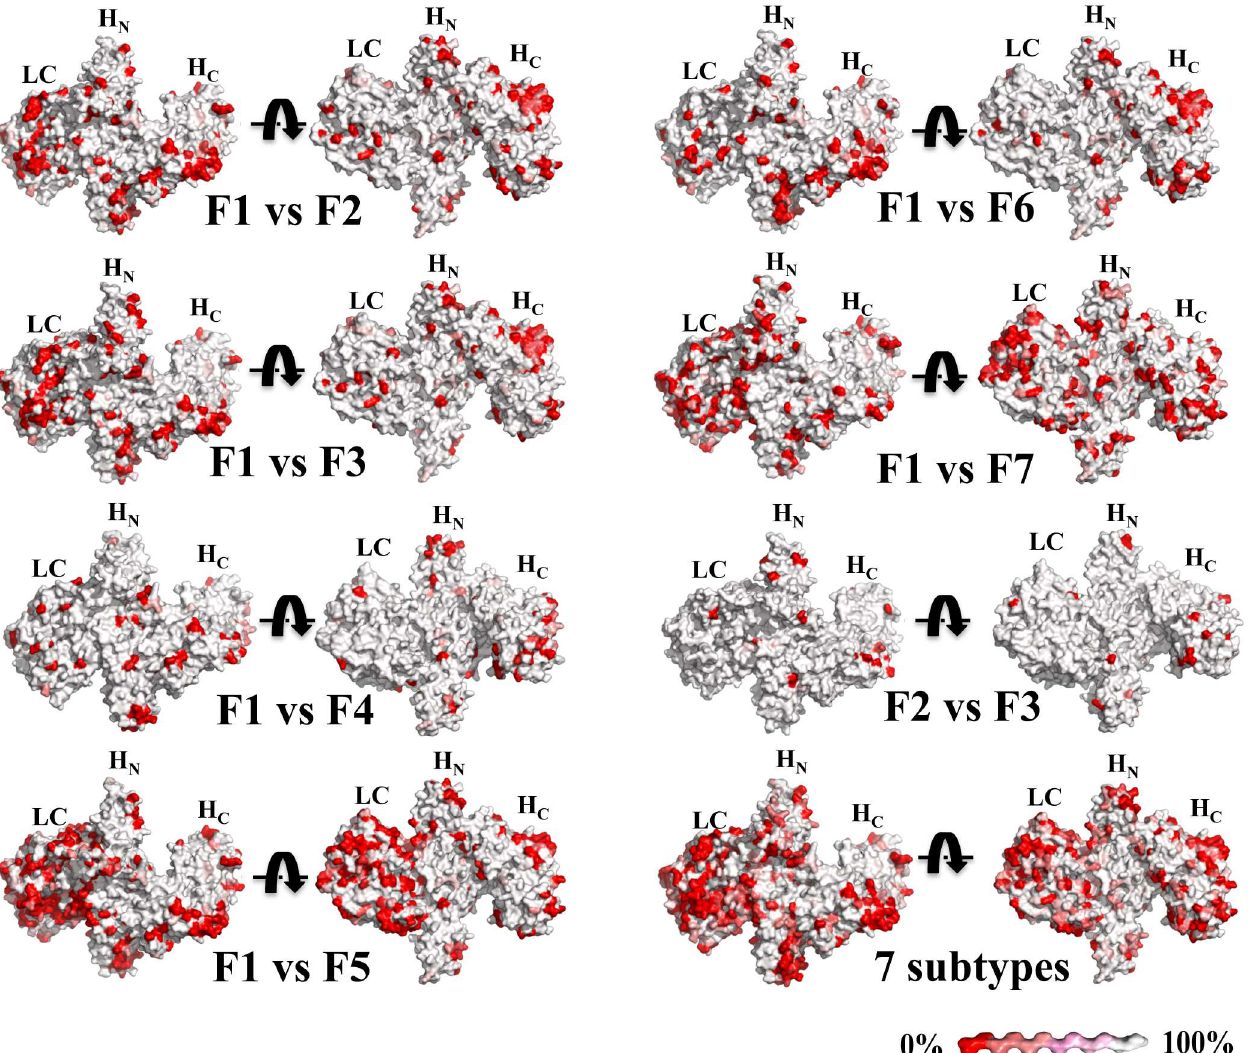
Fig 1. Comparison of the BoNT/F subtypes. The BoNT/F1 model was constructed by merging the BoNT/F1 LC crystal structure (pdb ID: 2A97) and a model of the BoNT/F1 LC-H N model based on the BoNT/A1 crystal structure (pdb ID: 2NZ9). BoNT/F subtypes were comparedto the BoNT/ F1 by using the tool MultAlin [31] and were visualizedusing ESPript 3 [32]. The physiochemical similarity of amino acids is indicatedon a color scale from white to red. The white indicates100%identity and the red indicates0% physiochemical similarity.